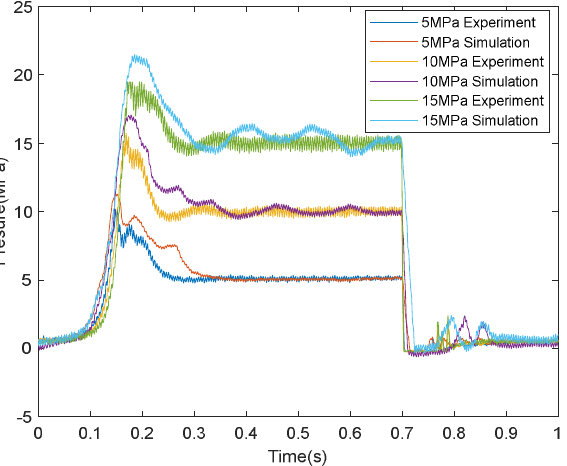
Figure 12. The characteristics of pressure response under an internal unloading condition.